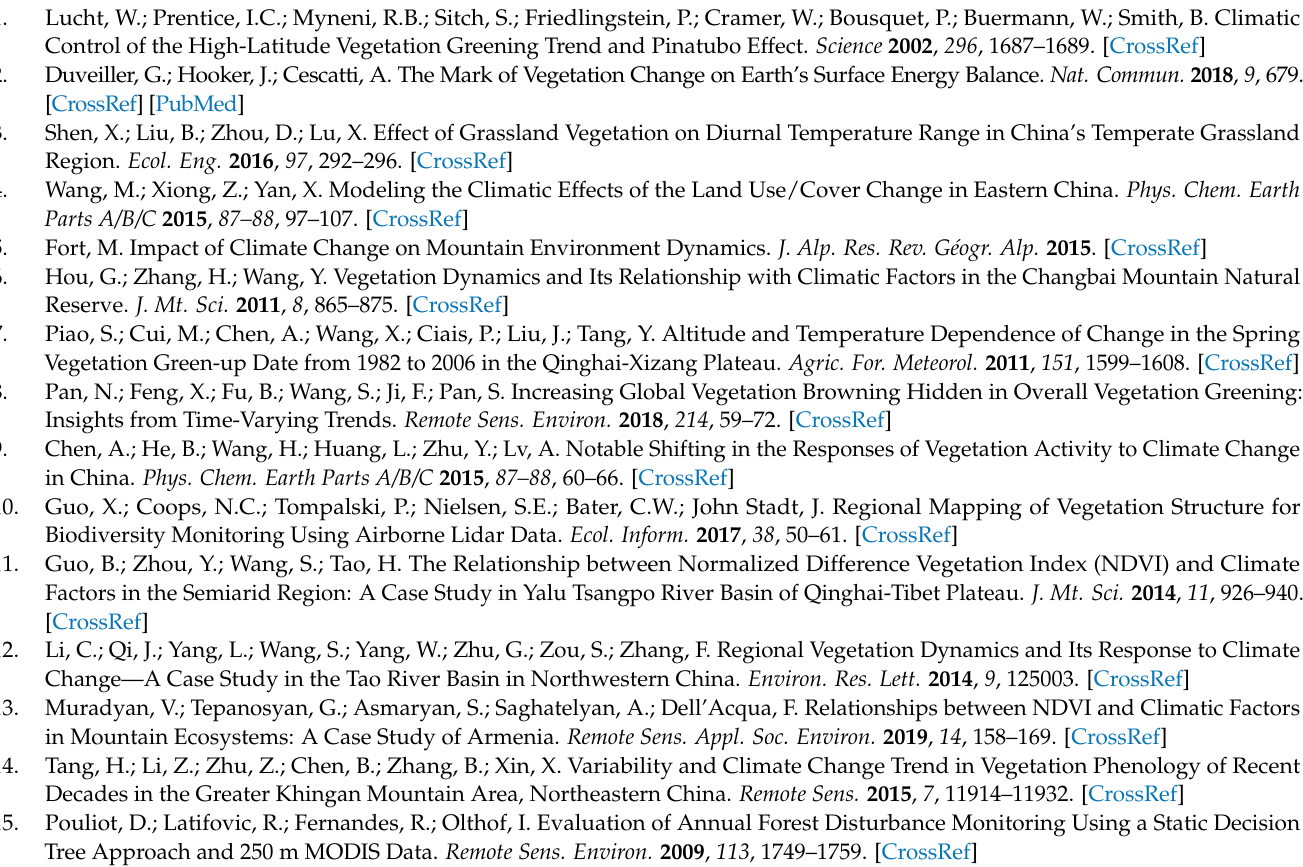
Table S8: Correlation between averaged monthly and periodic values of temperature and SR NDVI for Meghri, with the levels of significance: *— p < 0.05, ** p < 0.01; Table S9: Trend analysis based on LANDSAT NDVI time